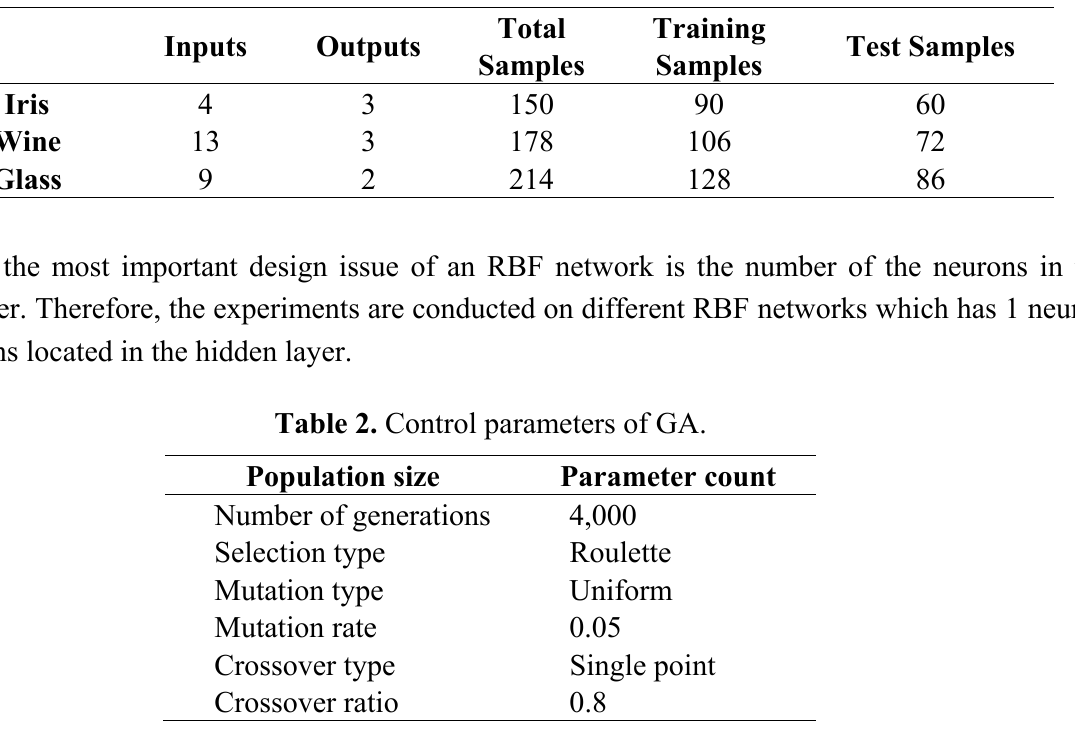
Table 1. Characteristics of the UCI dataset.